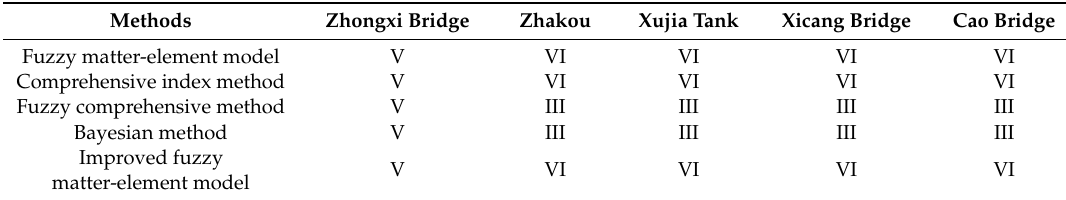
Table 4. Comparison of the assessment results of di ff erent methods.